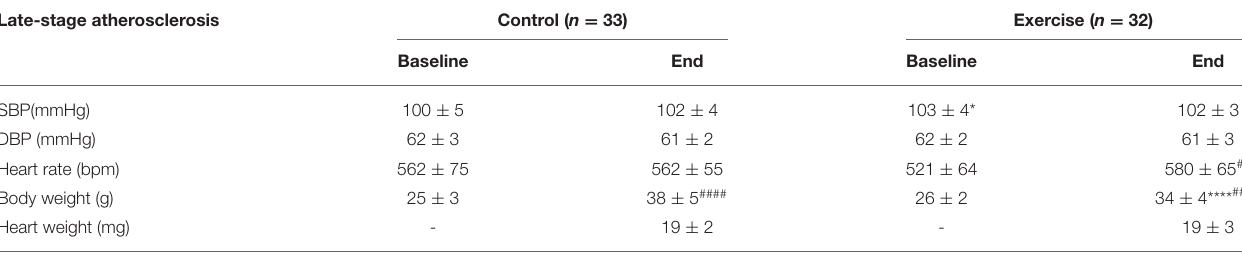
TABLE 3 | The effect of exercise on clinical parameters of the late-stage atherosclerosis mouse model. Late-stage atherosclerosis